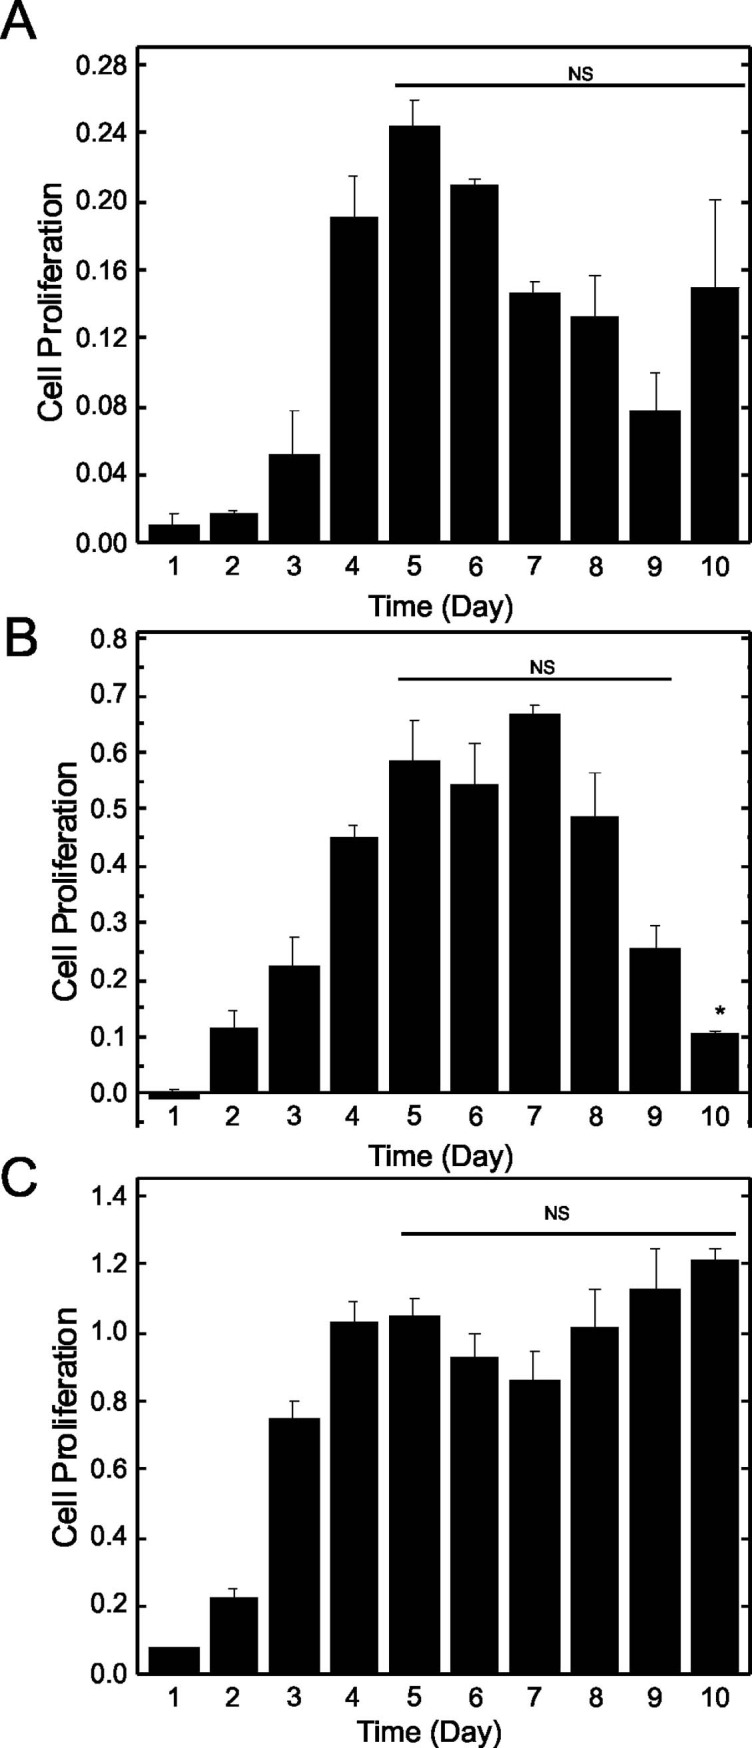
Effect of ECM substrate on proliferation of EA.hy926 cells.EA.hy926 endothelial cells were seeded at a density of 9000 cells/cm2 on non-coated (Panel A), Matrigel-coated (Panel B) or collagen-coated (Panel C) 96 well plates and grown for up to 10 days without changing the media. Cell proliferation was assessed with the BrdU cell proliferation assay. Plates were read at dual wavelength 450/550 nm. Data are plotted as means ± SEM (n = 3). NS, non-significant versus day 4; * significantly different (p <0.05) from day 4.